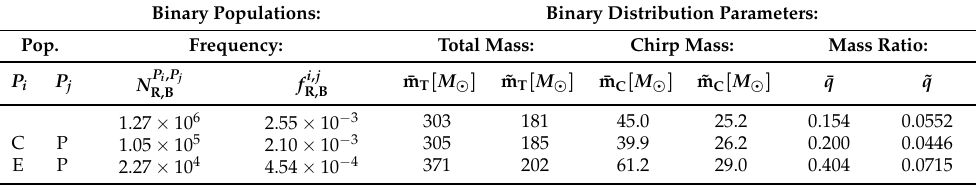
Table 12. Distribution mean and median values of the distributions in Figure 10, representing the binary profiles segregated by the population (cluster and ejecta) type integrated across all time-slices in the simulations starting at the burn-in time t BI = 2.64 × 10 5 yr up to the present, for a total of ∑ N R ( N ) = 2.32 × 10 6 binaries throughout all realisations. Note that we use our convention that C, B R i = 1 E, P, R and B stand for the cluster, ejecta, primitive, remaining and bounded populations, respectively. Note as well that we do not show the corresponding mean and median values of merged PBHs in bounded systems in this table as their number is negligible compared to the other cases, but we do show them, however, on Table